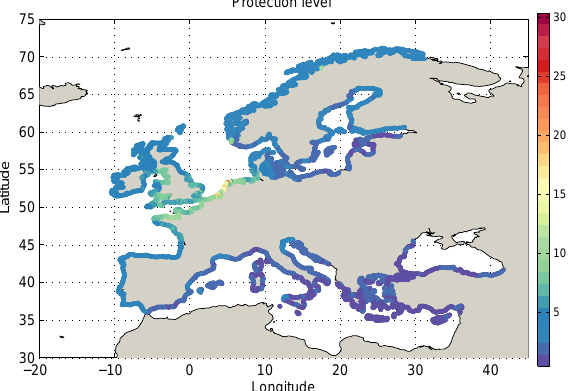
Figure 2. Protection standards considered along the European coastline, expressed as design total water levels